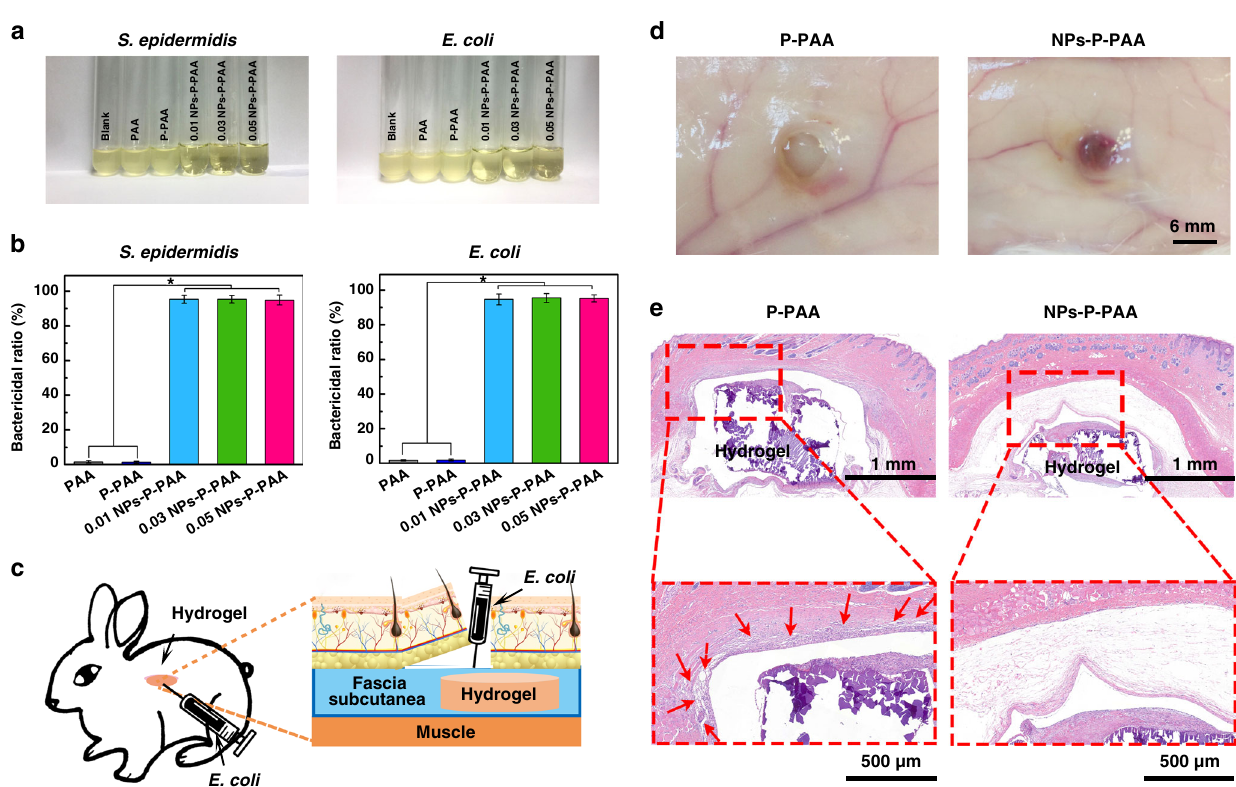
Fig. 4 The antibacterial activity of the hydrogel. a Photos of S. epidermidis and E. coli . solution co-cultured with the hydrogels after 1 day. b The bactericidal ratio of the hydrogels to S. epidermidis and E. coli . (Error bar means the standard deviation, * indicates statistically difference at p < 0.05, p value was generated by one ‐ way analysis of variance (ANOVA), followed by Tukey's multiple ‐ comparison post hoc test, n = 3). c Scheme of the in vivo antibacterial experiments. d Photographs of harvested hydrogels after they were implanted in the skin pockets for 7 days of post surgery. e Hematoxylin – eosin (H&E)- stained sections of connective tissues surrounding the